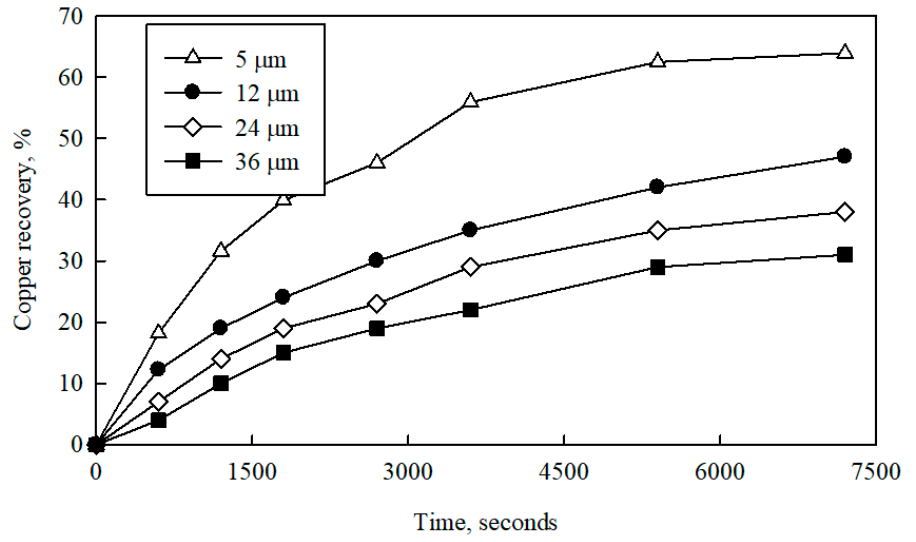
Figure 9. The effect of average particle size on copper recovery. Working conditions: NH 4 OH = 0.1 mol/dm 3 , temperature = 298 K, pH = 10.5, stirring rate = 500 rpm and S/L ratio = 1:1000.